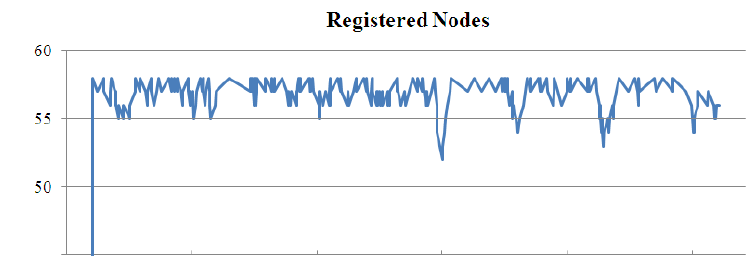
Figure 3. Sample evolution of registered PRIME nodes in a real field test subnetwork with 58 SN’s for 2